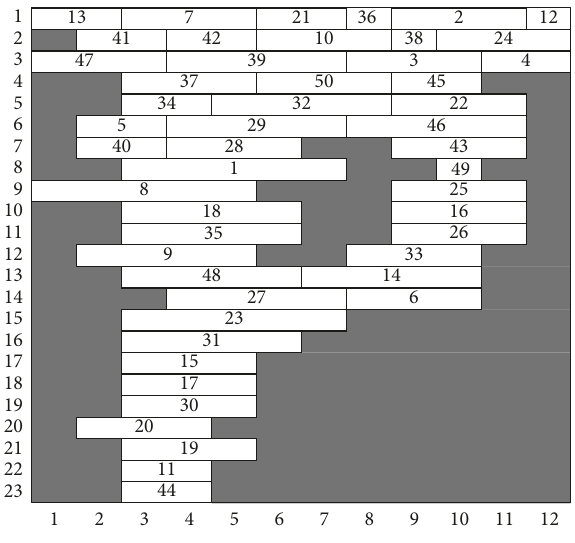
Figure 14: Usage of parking lot in mode r ∗